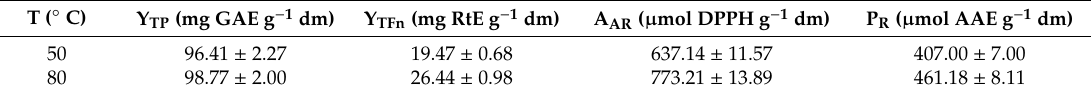
Table 5. E ff ect of extraction at 80 ◦ C on total polyphenols (Y TP ), total flavonoids (Y TFn ), ferric-reducing power (P R ), and antiradical activity (A AR ) of the extracts produced with La-Gly (5:1), under optimized